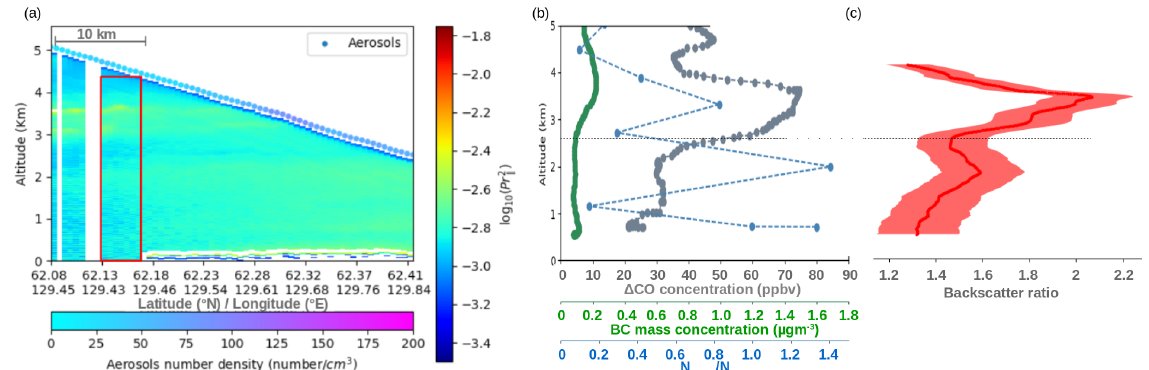
( PR 2 ) on 19 July 2013 at 11 UT above Yakutsk. Calibration constant is Figure 22. ( a ) Vertical cross-section of aircraft log 10 127,216 ± 5%. Grimm aerosol concentrations in particle.cm − 3 are shown at the aircraft altitude. ( b ) Vertical profiles of ∆ CO in ppbv (grey), BC in µ g.m − 3 (green) and ratio of N 80 − 200 /N A (blue dashed line) for the descent from 5 km to 0.5 km at 130 ◦ E. ( c ) Backscatter ratio vertical profile for the lidar data in the red box. The horizontal dotted line is the bottom of the upper aerosol layer at 3.5 km according to the lidar